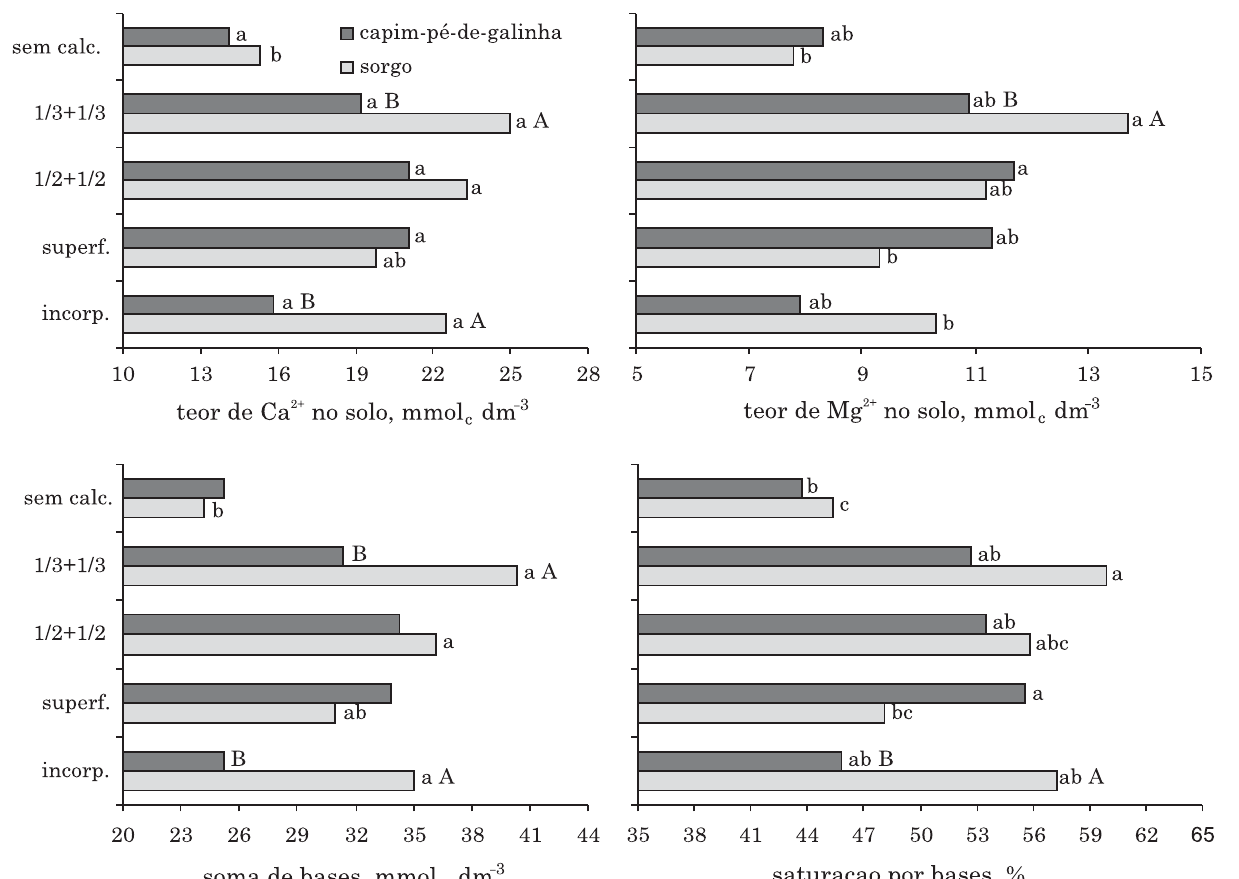
Figura 3. Teores médios de Ca 2+ , Mg 2+ , soma de bases e saturação por bases, considerando interação entre modos de aplicação de calcário na implantação do sistema plantio direto e culturas de cobertura do solo (letras minúsculas distintas, diferença entre os modos de aplicação de calcário; maiúsculas distintas diferença entre as culturas de cobertura Tukey a 5